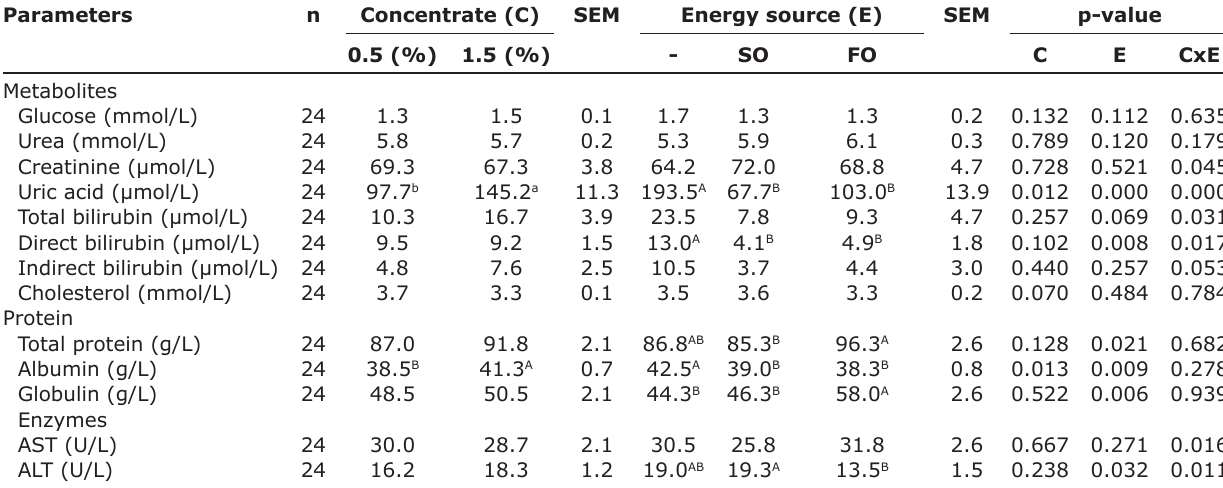
Table-2: Enzyme activities and concentrations of proteins and metabolites in blood of cattle supplemented with different concentrate levels and energy sources (n=24).